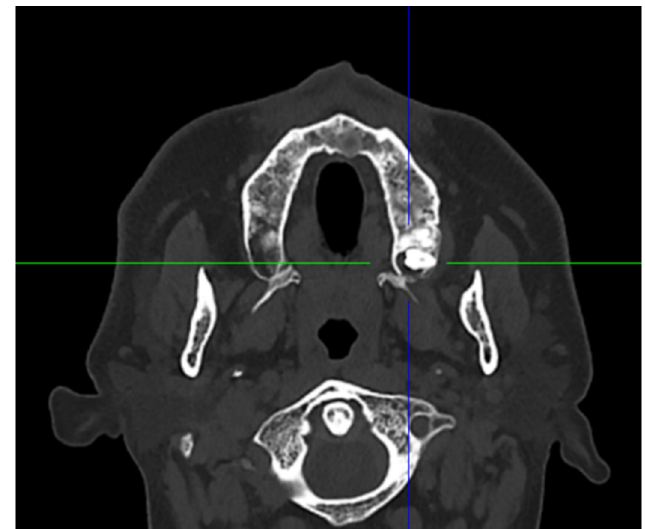
Figure 2. Axial CT Scan.